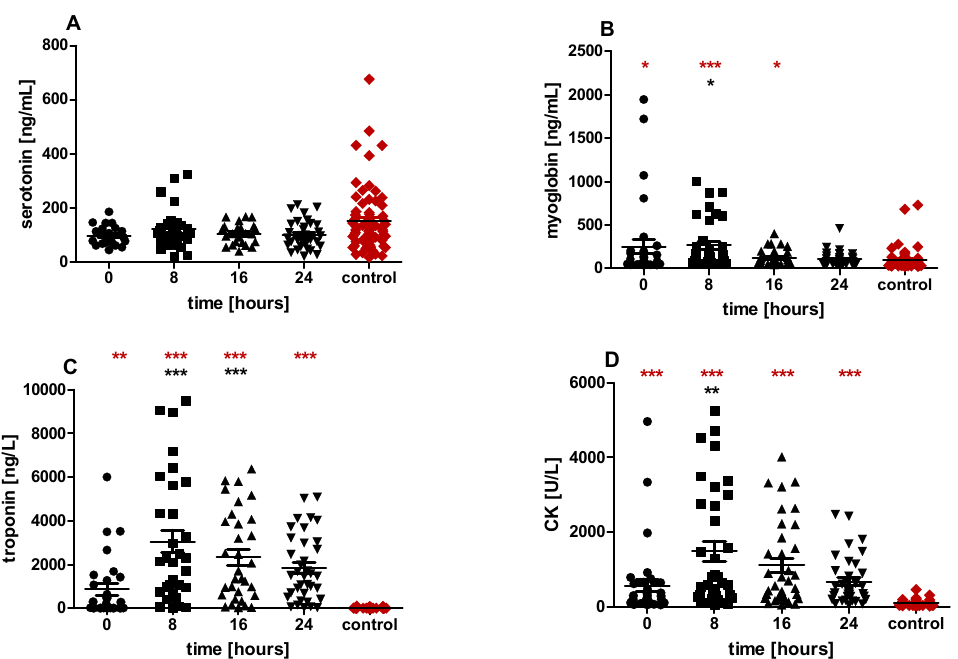
Figure 1. Analysis of serum samples prior to coronary angiography (t = 0) and 8, 16 and 24 h after intervention in the STEMI group (depicted in black) and in an age-matched control group (depicted in red). Serum serotonin ( A ), myoglobin ( B ), troponin ( C ), and CK ( D ) were analyzed. After STEMI, serum serotonin showed no increase or decrease within the 24 h interval compared to the control group or compared to t = 0 ( A ). Myoglobin, troponin, and CK showed a significant increase after coronary angiography compared to t = 0 and compared to the control group. * p < 0.05, ** p < 0.01, *** p < 0.001 compared to t = 0, * p < 0.05, ** p < 0.01, *** p < 0.001 compared to control group.